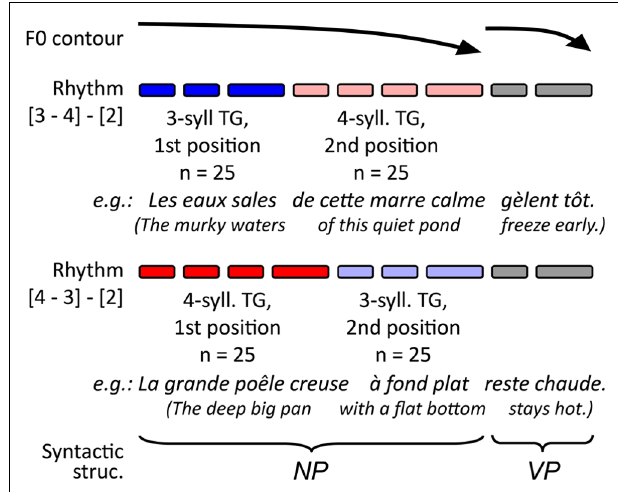
FIGURE 1 | Schematic representation of intended prosodic structure of the stimuli and the origin of the